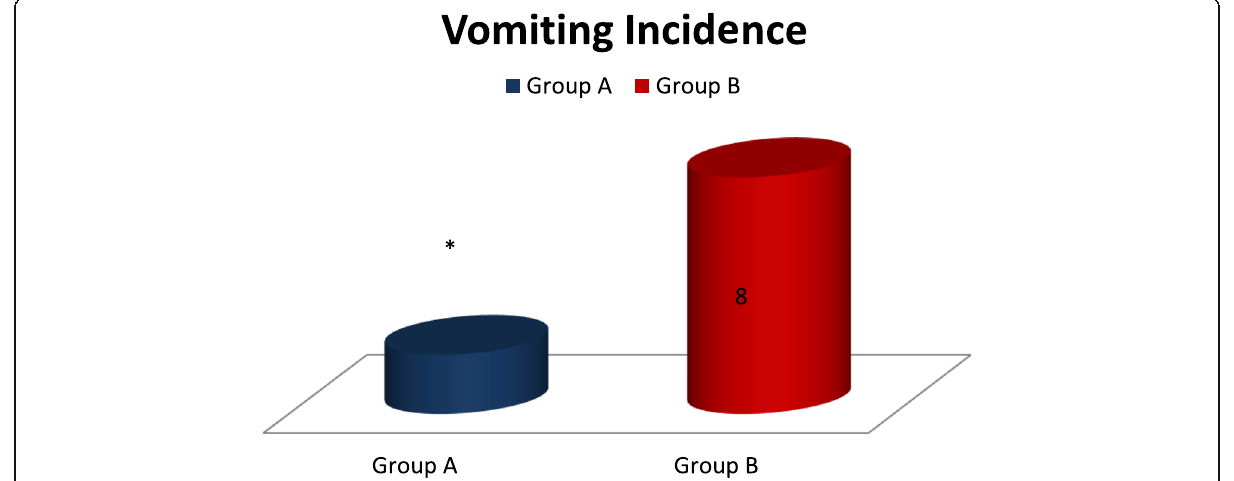
Fig. 4 Vomiting in both groups. Data were expressed as count. * P <